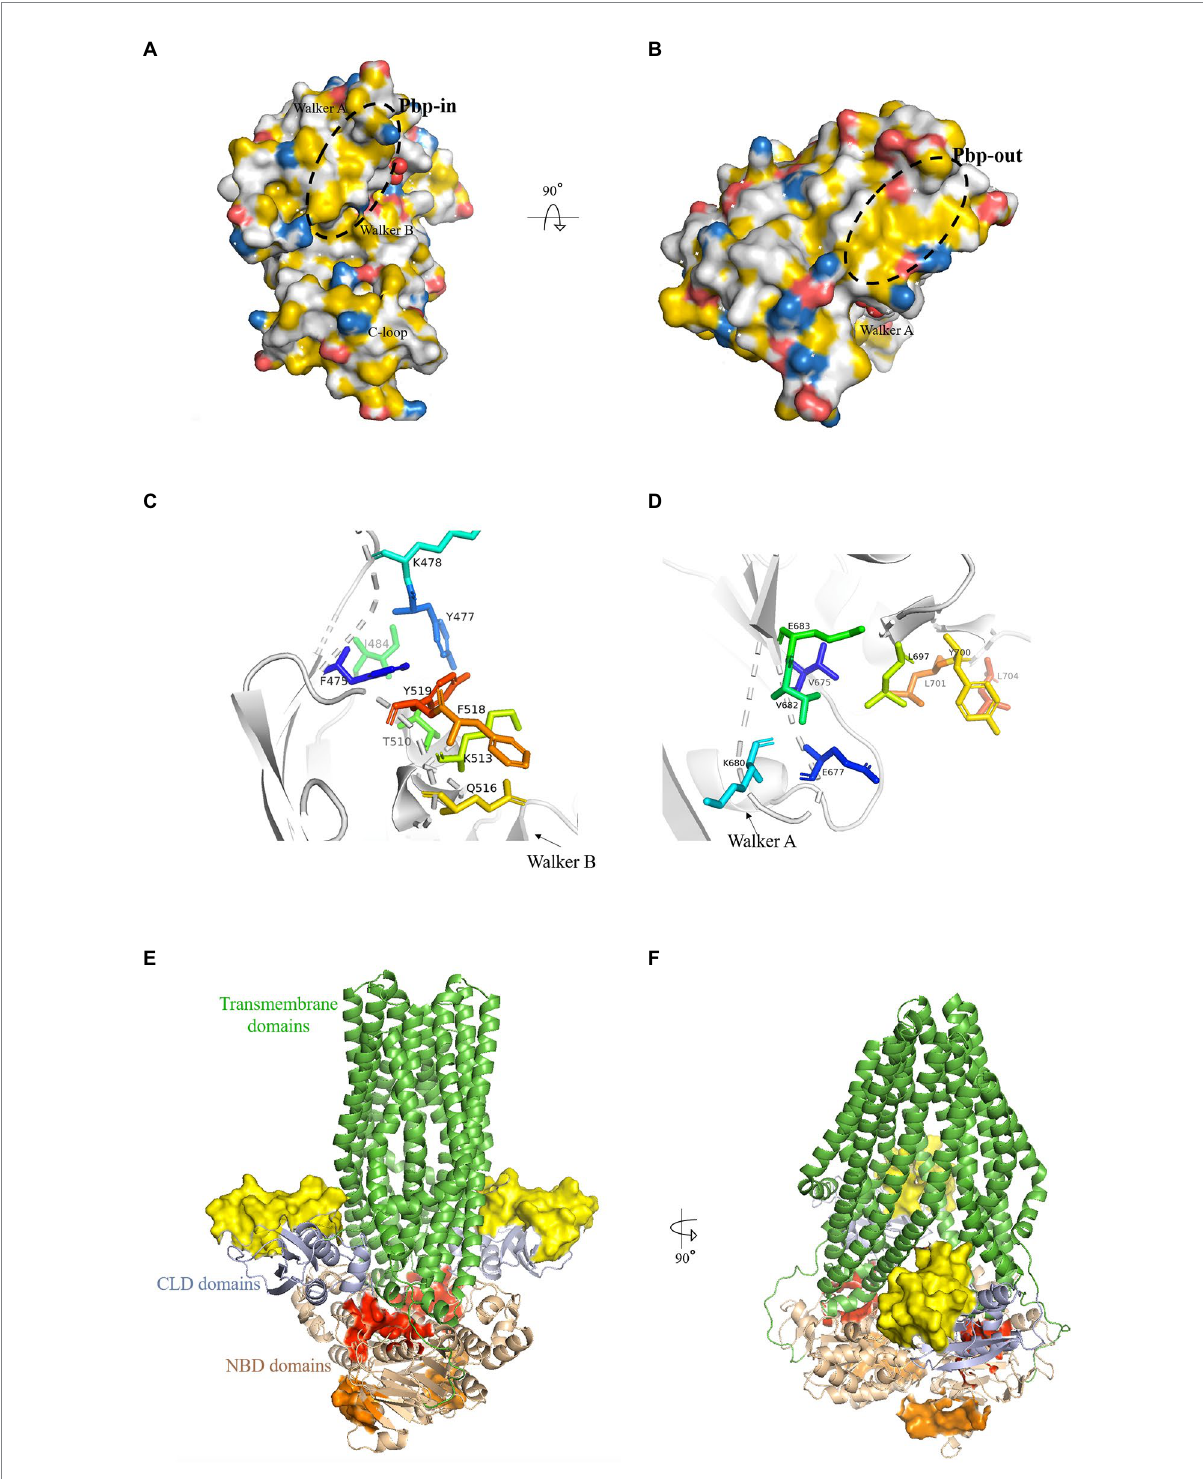
FIGURE 1 Putative binding pockets (pbp) of HlyB NBD. (A,B) The HlyB NBD monomer (1MT0) is shown in surface representation. The surface was colored with the YRB-script (Hagemans et al., 2015), which highlights carbon atoms that are not bound to oxygen or nitrogen in yellow, the charged oxygens of Glu and Asp in red, the charged nitrogen of Lys and Arg in blue while all other atoms in white. The structural elements of the NBD were labeled. The pbp’s are circled with a black dashed line. From panel A , which shows the pbp-in, to panel B , which shows the pbp-out, the molecules have been rotated toward the reader. (C,D) The residues of pbp-in (C) and pbp-out (D) from the monomeric structure (1MT0) are shown as stick representations. (E,F) Cartoon representation of a model of HlyB based on PCAT1 shown in green (Lin et al., 2015). The identified pbp’s are shown as surface representation with pbp-in in red and pbp-out in orange. The yellow surface maps the HlyA-interaction region on the CLD (Lecher et al., 2012). Pale colors correspond to the same regions in the second monomer. The overall domains of HlyB were